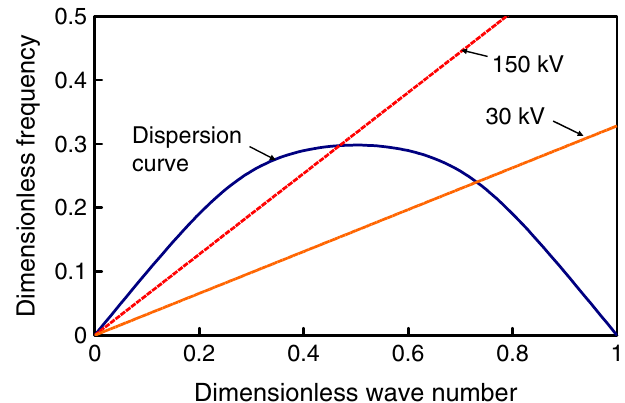
FIG. 3. (Color) Dimensionless grating dispersion curve ( !=cK versus k=K ) and electron beam lines for 30 and 150